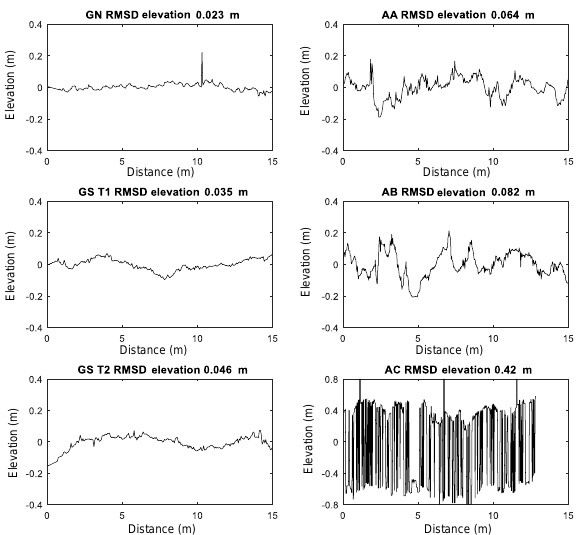
Figure 5. Deviations from the local robust linear trend (based on 15m moving window) of densified point cloud elevations along each transect. Only the first 15m of each transect is shown for clar- ity. The root-mean-square deviation (RMSD) for elevations over the entire transect is also indicated. AC is truncated as the transect con- sisted of shorter line segments.